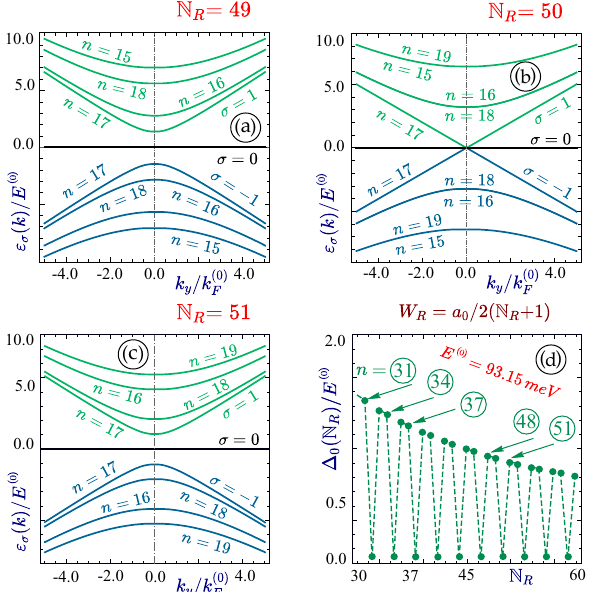
Figure 2. Calculated low-energy subbands ε σ n ( k y ) of α W R . Panels ( a ) through ( c ) present dispersion relations of some low-energy subbands as functions of the longitudinal wave vector k y for ribbons with N R calculated half-bandgap � 0 ( N R ) of nanoribbons between the lowest conduction and the middle flat subband for various selected N R values. In our computations, we set units as k